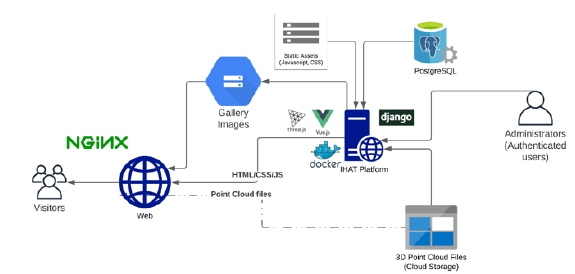
Figure 12. IH-AT system architecture.